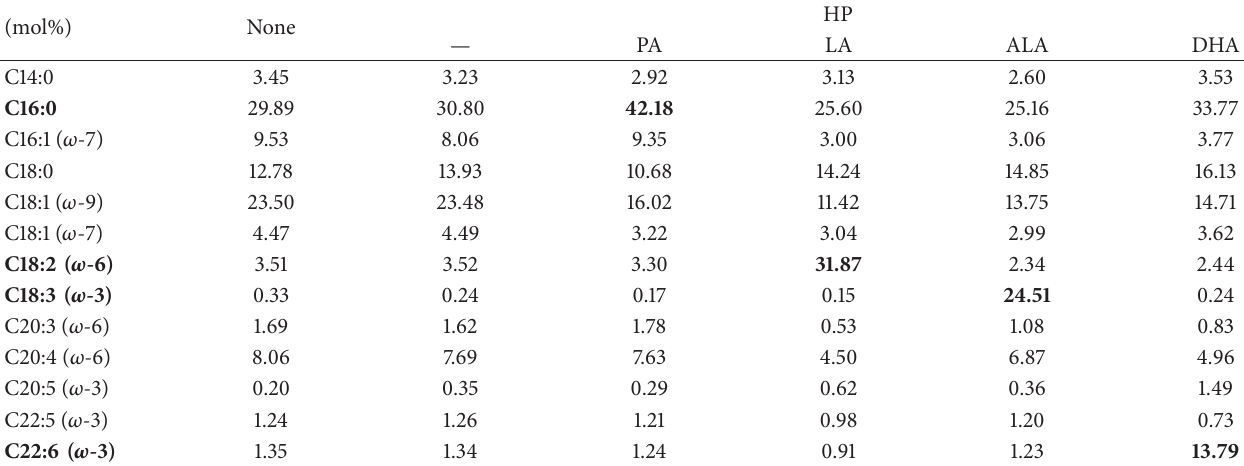
Table 1: Relative fatty acid composition of phospholipids in AGS